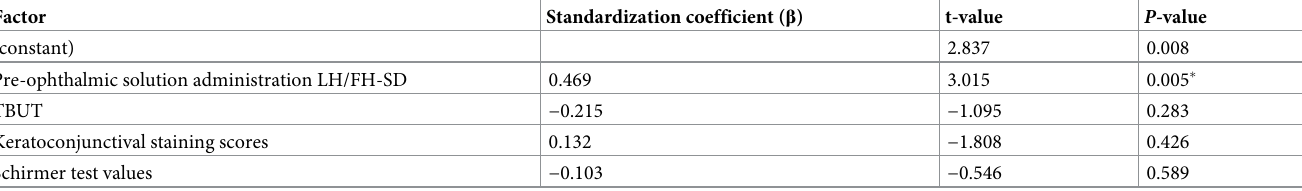
Table 3. Multiple regression analysis for determining factors affecting the J-OSDI scores.